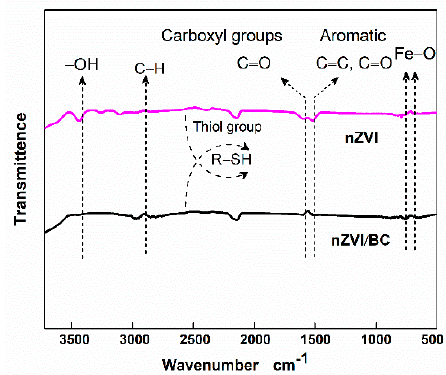
Figure 2. FTIR analysis of nZVI and nZVI/BC.